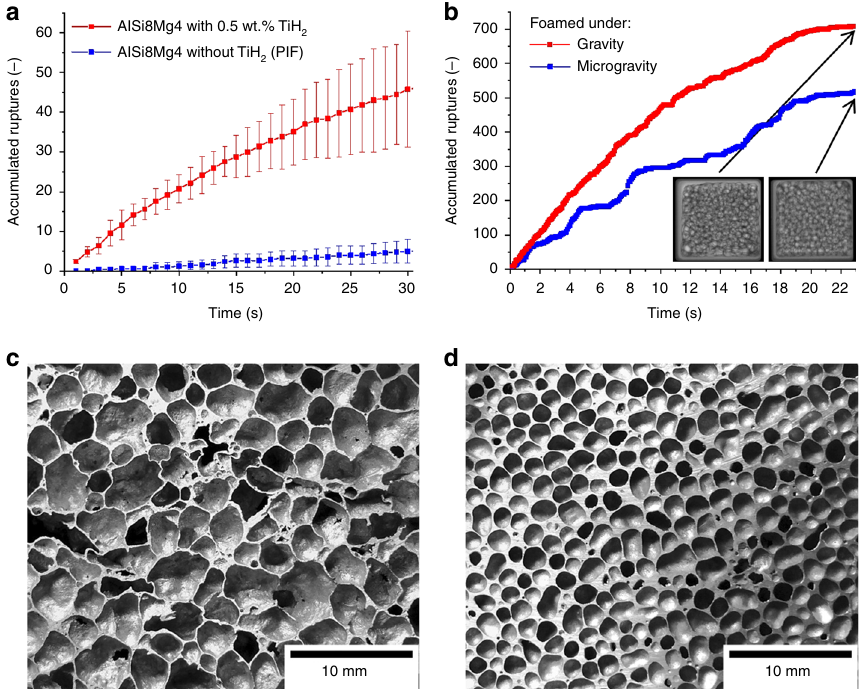
Fig. 5 Experiments proving that coalescence is caused both by the blowing agent and gravity. a Cumulated number of fi lm rupture events in AlSi8Mg4 foams determined by evaluating X-ray radioscopies over a period of 30 s. Samples of similar porosity foamed with TiH 2 are compared with samples foamed without. In the latter case, volume expansion was supported by a pressure drop imposed on the sample (pressure-induced foaming — PIF) 33 . Five experiments were averaged, error bars correspond to the standard deviation. b Film rupture events in AlCu10Mg15 foam determined by analysing X-ray radioscopies obtained under normal and microgravity conditions, both at ambient pressure. Two images are shown for the fi nal state marked by arrows. c Cross-section of an AlSi8Mg4 foam blown with TiH 2 compared with d AlCu10Mg15 foam produced without TiH 2 featuring a more homogeneous distribution of smaller